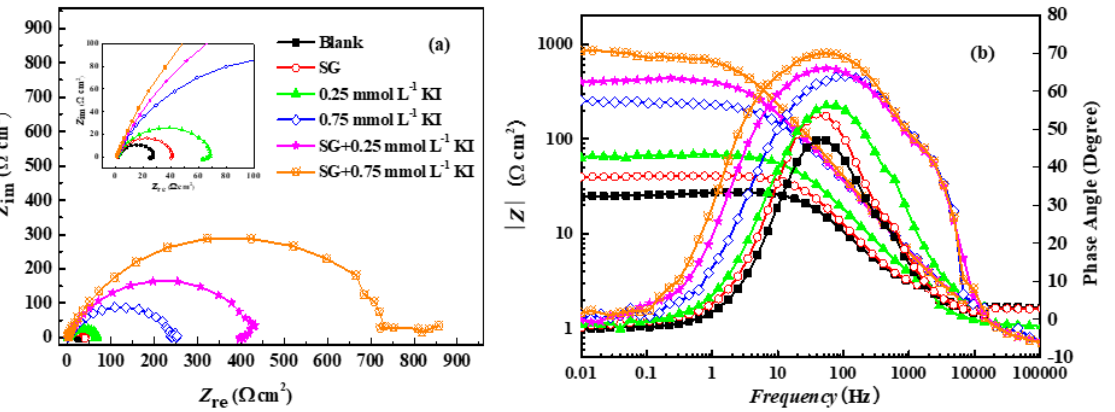
Figure 5. EIS of the electrodes in 0.5 mol L − 1 H 2 SO 4 solution without and with different corrosion inhibitor formulations: ( a ) Nyquist diagram; ( b ) Bode plots.